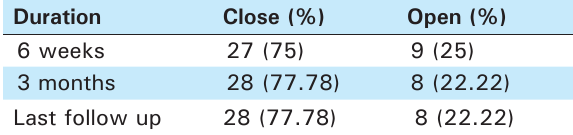
Table 5 . A natomical status of macular hole following